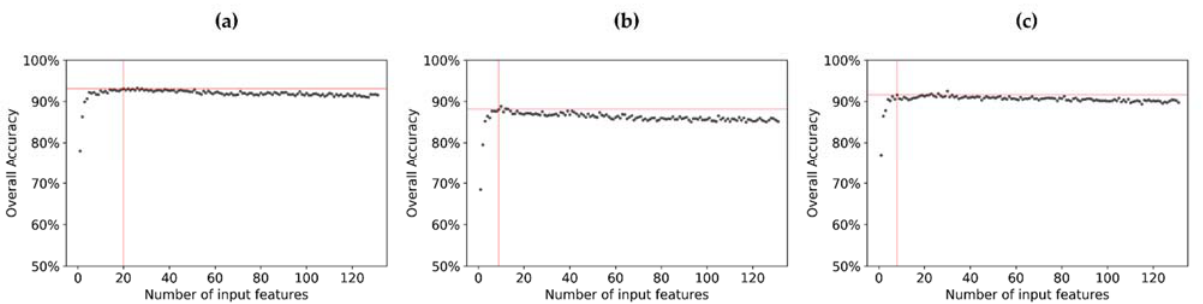
Figure 7. Results of the Random Forest model for recursive feature selection to distinguish between intensive and extensive grassland classes, starting with the model based on all available features from combined optical and radar data and environmental data for 2017 ( a ), 2018 ( b ) and 2019 ( c ). The red lines show the selection of the final chosen model and the corresponding number of input features.